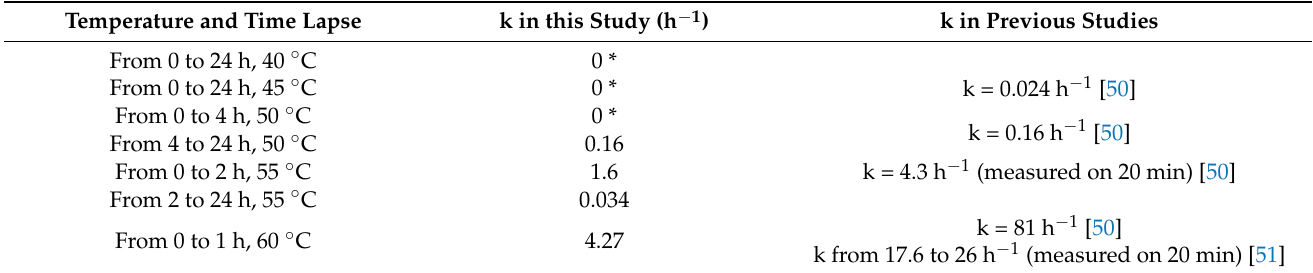
Table 1. Inactivation kinetic constants of L. pneumophila for temperatures between 40 ◦ C and 60 ◦ C. Sanden et al., 1989 [50] is for a strain of L. pneumophila serogroup 1 isolated from cooling tower water, inactivation measured in chlorine-free water. Stout et al., 1986 [51] is for 3 L. pneumophila strain of serogroup 5, inactivation measured in Buffered Yeast Extract Broth